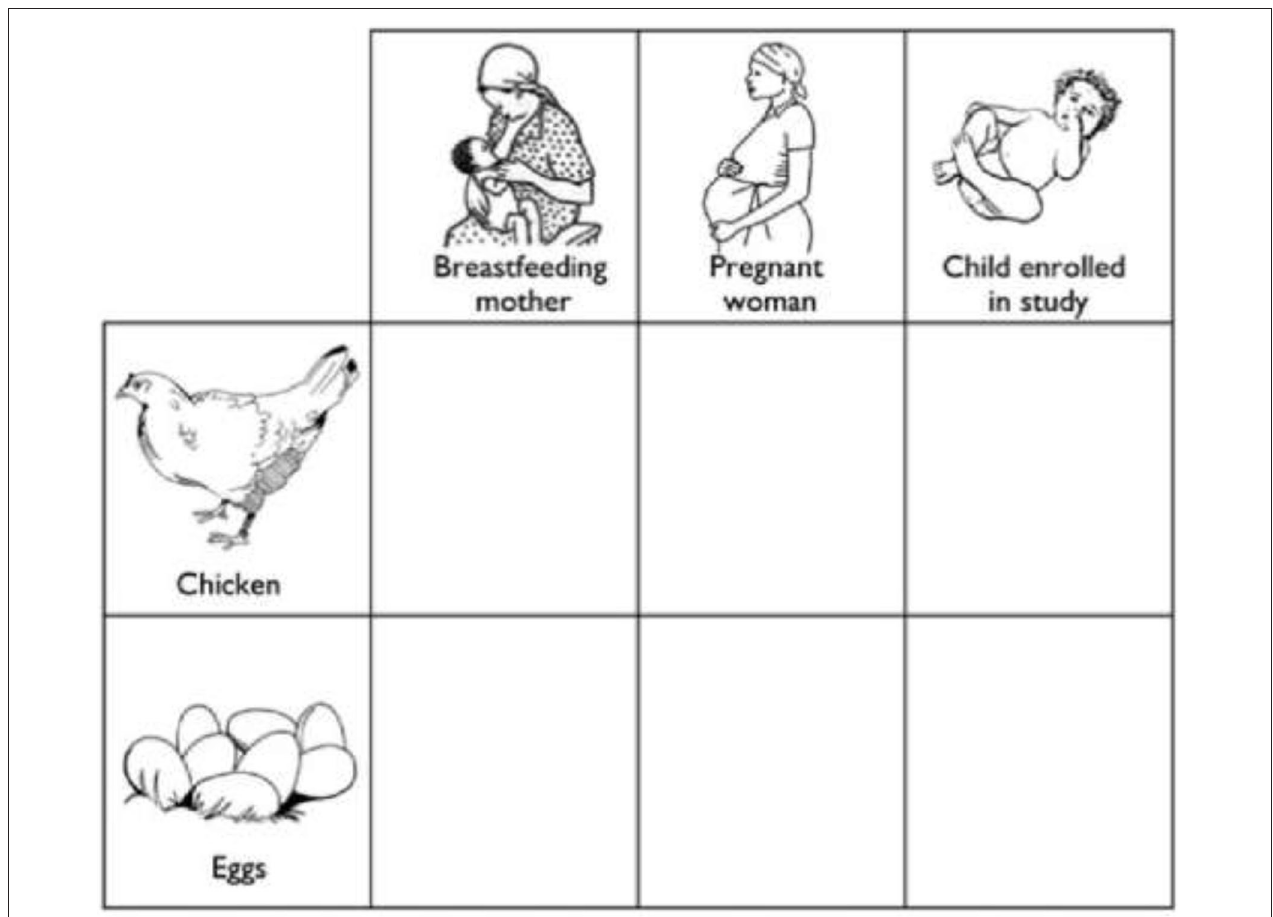
FIGURE 1 | A copy of the pictorial record chart (with English translations of Swahili text) for completion by a household representative, to record the consumption of poultry products by children enrolled in the study, and any pregnant or breastfeeding women within the same household [Source: (